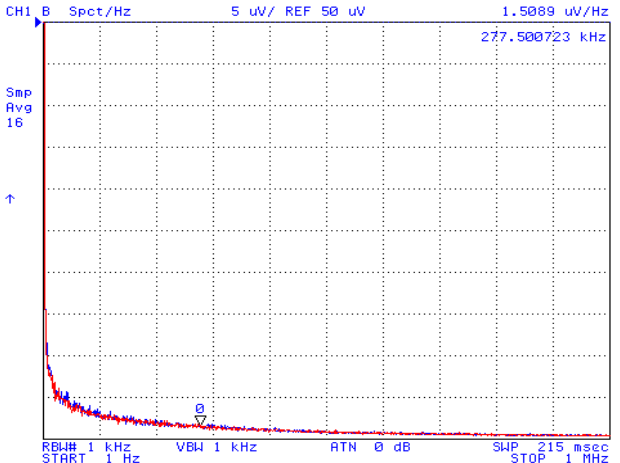
Figure 5. Measured noise variations for both voltage outputs versus frequency (red line— V o1 , blue line— V o2 ).